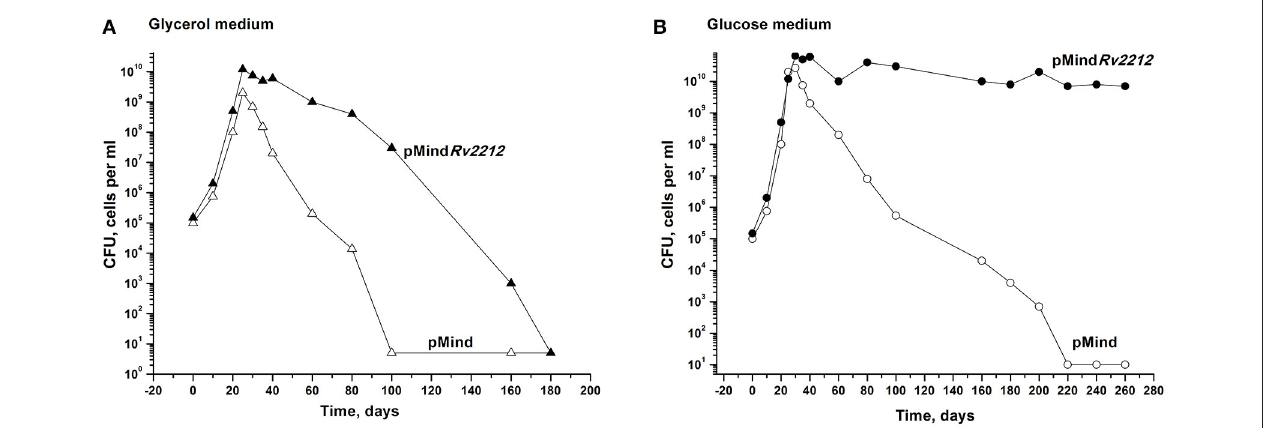
FIGURE 2 | Overexpression of Rv2212 influences transition of M. tuberculosis to dormant “non-culturable” state. Recombinant Mtb strains containing pMind Rv2212 vector (closed circles) or empty pMind vector (open circles) were grown in “glycerol” (A) or “glucose” (B) modified Sauton’s media with agitation (200 rpm) at 37 ◦ C. For details see Materials and Methods. Minimum threshold for CFU determination was 10 cells per ml. SEM for the CFU determination was < 20%. Experiments shown in (A) and in (B) were repeated two times and four times, respectively. Typical results are shown.